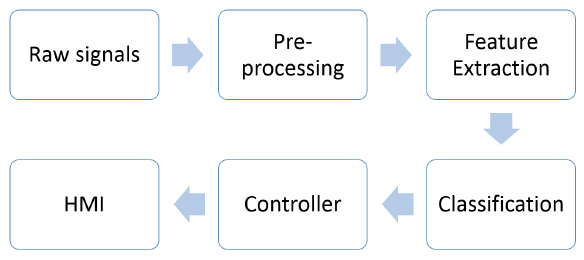
Figure 5. An overview in developing EMG control